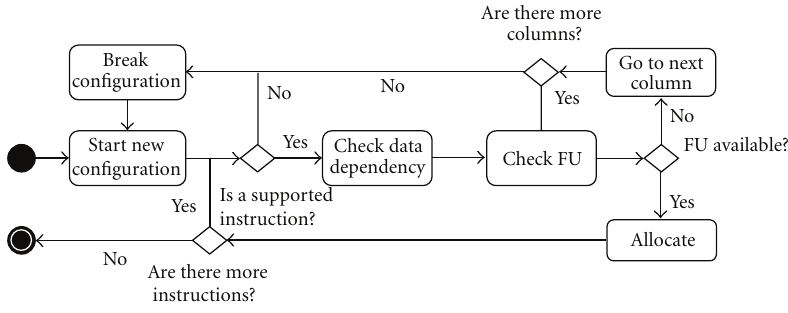
Figure 3: DIM activity